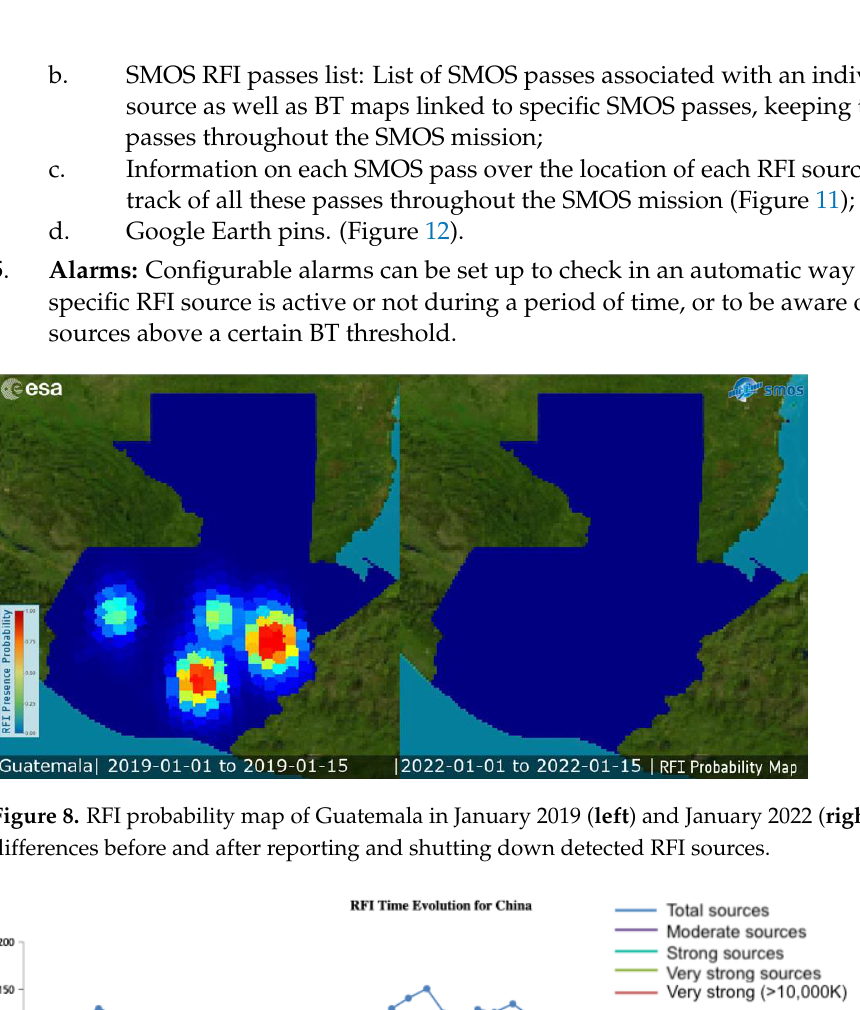
Figure 7. ERMIT home page.